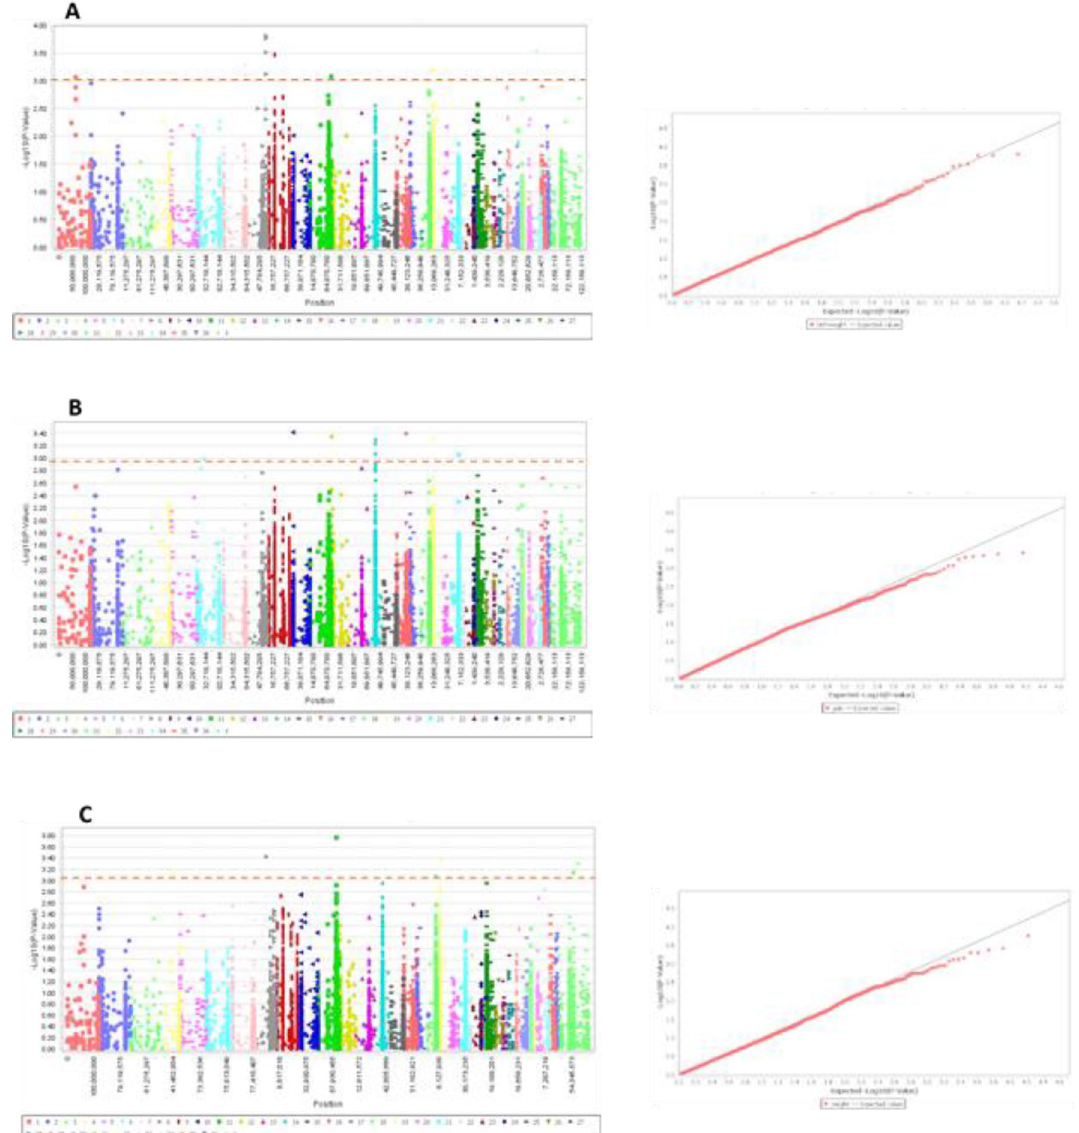
Figure 6. Manhattan plots and q-q plots of birth weight, daily gain, and body weight traits for Dromedary Camels. ( A ) birth weight; ( B ) daily gain; ( C ) body weight. The dotted horizontal line represents the set significant threshold (–log 10 p value = 3). Red dots in the q–q plots represent the -log p-value of the entire study and the grey line represents the expected values under the null hypothesis of no